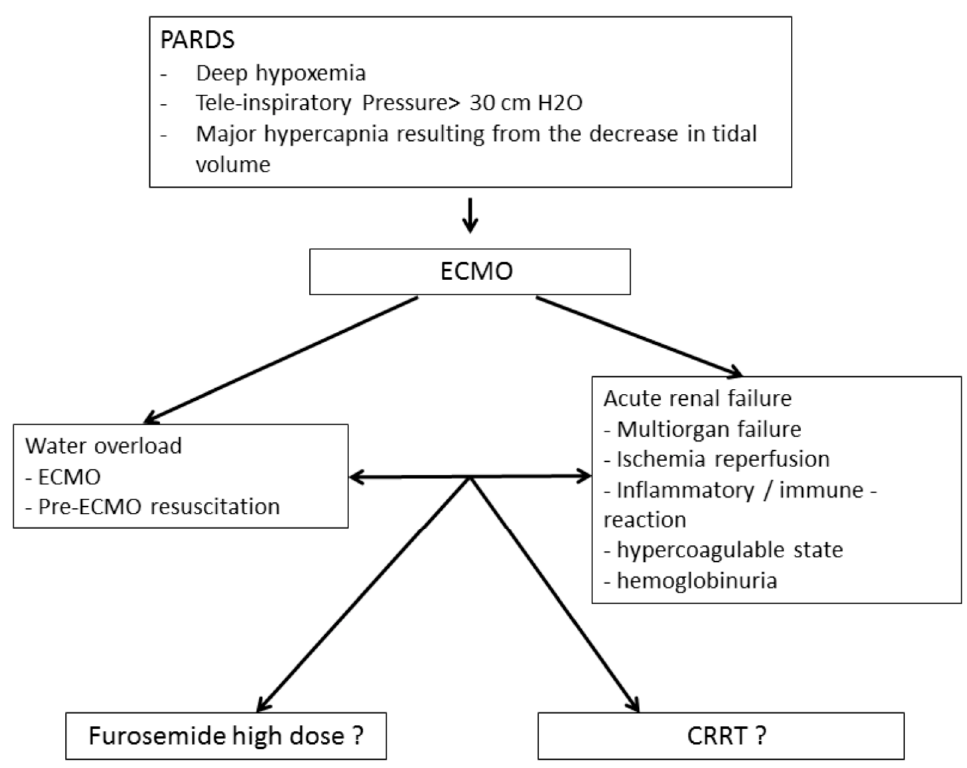
Figure 1. Principle of setting up an ECMO coupled with extra-renal purification.